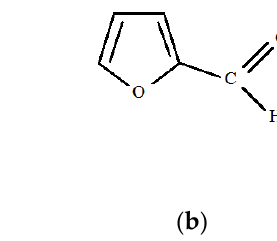
Figure 1. Structural formula: ( a ) 1,3,5-trioxybenzene; ( b ) 2-furaldehyde. Determination of the plasticizing ability of the additive was based on Portland cement grade CEM I 42.5. The specific surface area of the Portland cement was 250 ± 10 m 2 /kg.